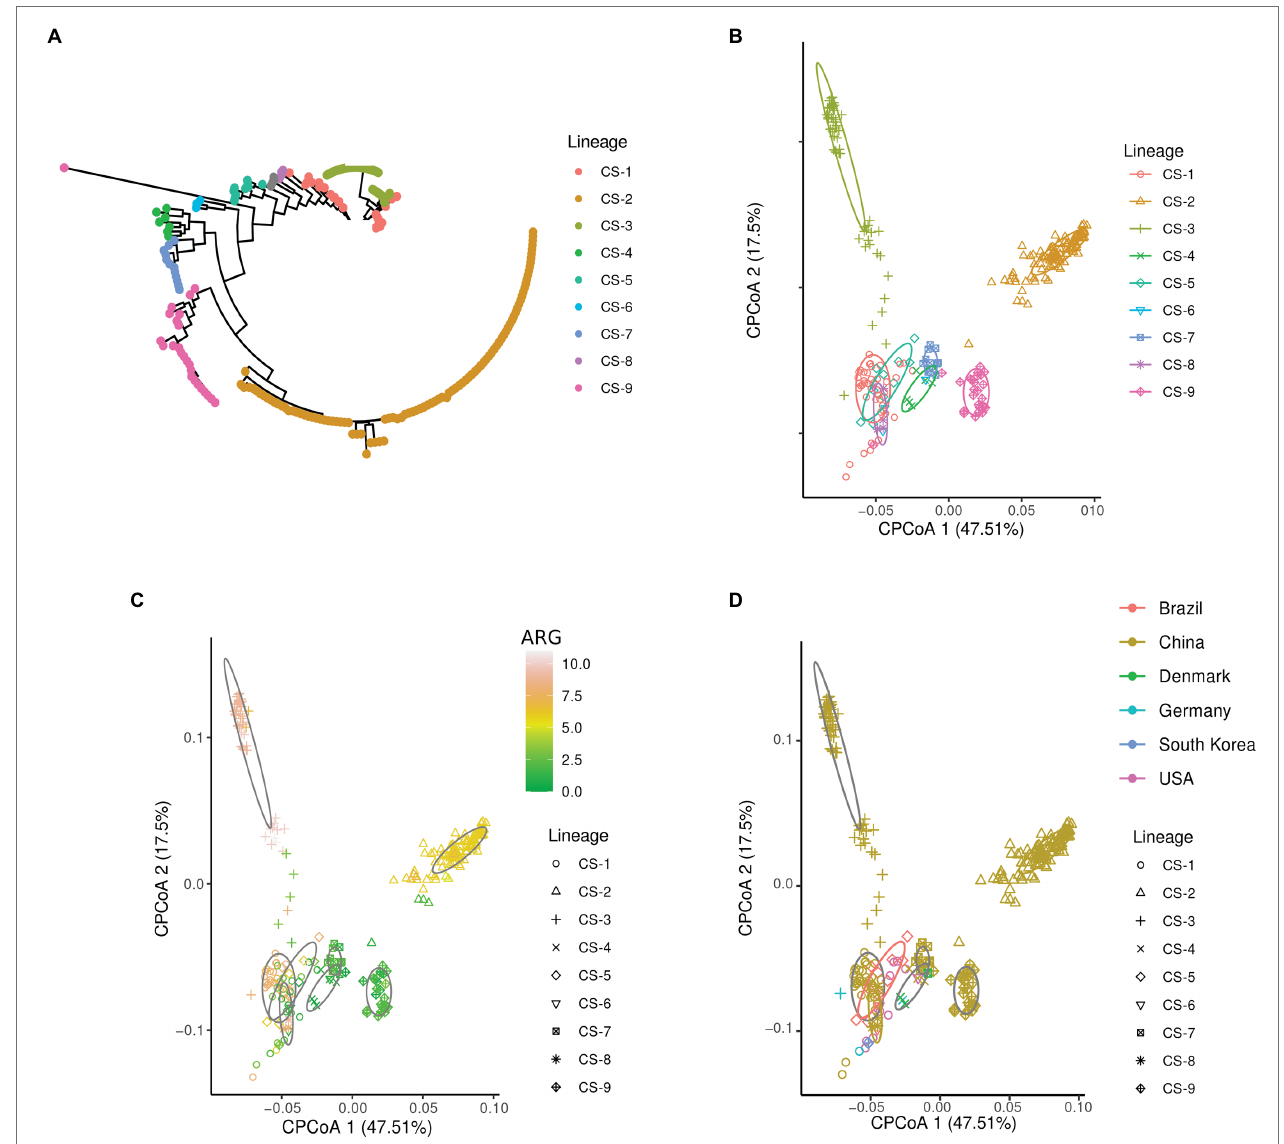
FIGURE 1 | Relationship of IS with epidemiological characteristics. (A) Lineages of Corynebacterium striatum . (B–D) Constrained principal coordinate analysis (CPCoA analysis). Lineages were determined using the R package, RhierBAPS (Tonkin-Hill et al., 2018) using a masked alignment generated by Gubbins (Croucher et al., 2015), and phylogenetic tree generated by IQ-TREE (Nguyen et al., 2015). The CPCoA analyses (ANOVA-like permutation analysis, value of p < 0.0004, and 24.9% of variance) were constructed from the presence and abundance of IS in the C. striatum genomes and explored according to the metadata available and retrieved from different sources in this study. Briefly, we obtained the C. striatum genomes available at NCBI (07/26/2021), made the annotation with Prokka (Seemann, 2014) and constructed its pangenome with Panaroo (Tonkin-Hill et al., 2020). The presence and abundance of insertion sequences were extracted from the pangenome. For phylogenetic reconstruction, we align the core-genome using Parsnp (Treangen et al., 2014), and we build a tree based on core-genome alignment using IQ-TREE. The presence of resistance genes was extracted from the metadata available from the